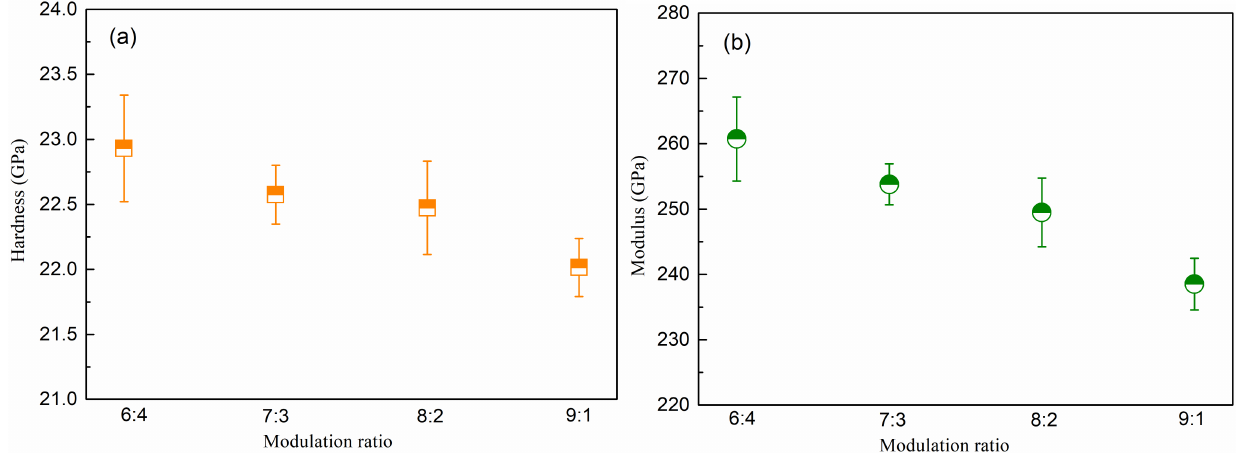
Figure 5. ( a ) Hardness and ( b ) Modulus of Mo/VC multilayers with varied modulation ratios from 6:4 to